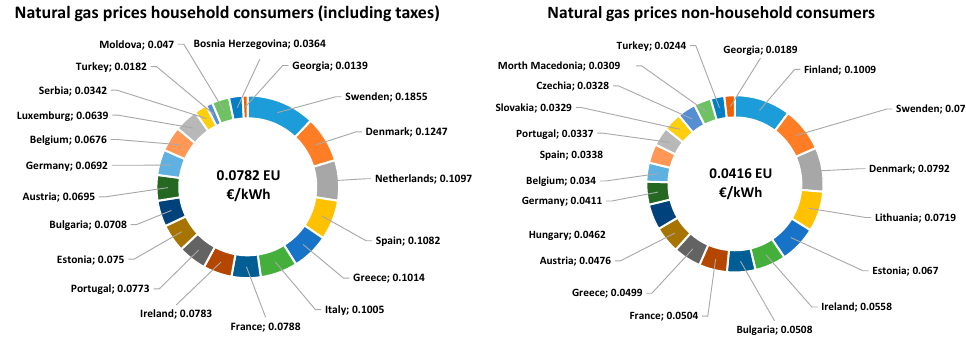
Figure 7. Natural gas prices household and non-household consumers (Eurostat) [38].